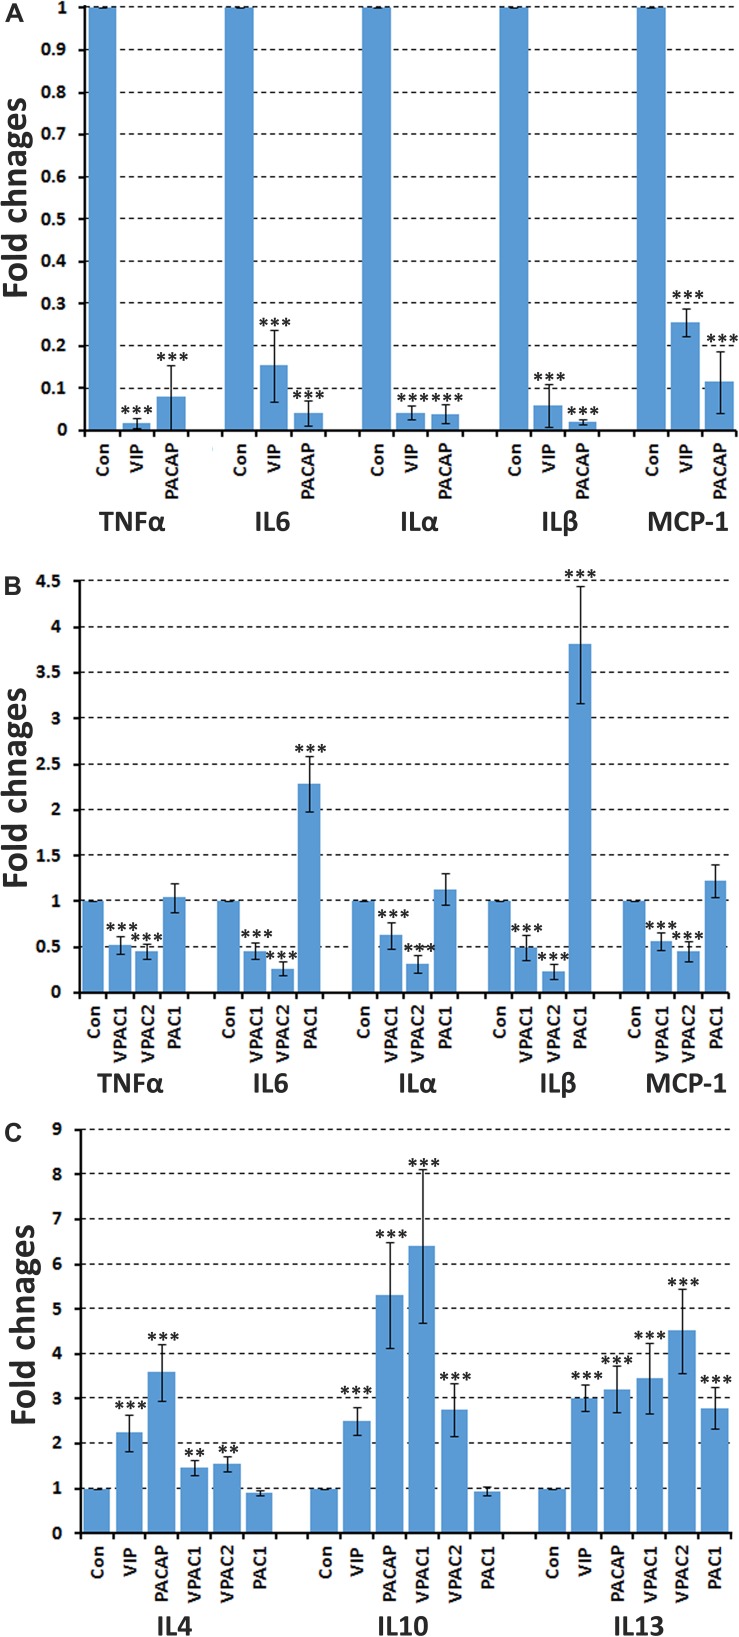
VIP and PACAP regulate pro-inflammatory and anti-inflammatory cytokine expression in nerve explants. (A) 24 h treatment with VIP or PACAP inhibit TNFα, IL6, ILα, ILβ, and MCP-1 expression in cultured sciatic nerve explants. Sciatic nerve explants were cultured from uninjured mouse sciatic nerve. (B) 24 h treatment with VPAC1 or VPAC2 receptor-specific agonist treatment inhibits TNFα, IL6, ILα, ILβ, and MCP-1 expression in cultured sciatic nerve explants. In contrast, PAC1 receptor specific agonist treatment induces IL6 and ILβ expression. Sciatic nerve explants were cultured from uninjured mouse sciatic nerve. (C) 24 h treatment with VIP, PACAP or receptor specific agonists induce anti-inflammatory cytokines IL4, IL10, and IL13 expression in nerve explants. Nerve explants were cultured from the distal nerve stump at 10 days post-transection injury. All samples were normalized to GAPDH and control samples were made relative to 1. n = 3. ∗∗P < 0.01, ∗∗∗P < 0.001. 27 mice were used in (A,B) for nerve explant culture, and 54 mice were used in (C) for nerve explant culture.